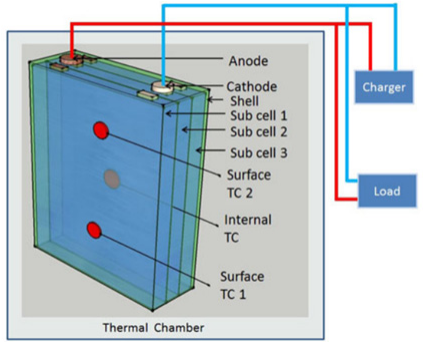
Figure 2. Configuration of battery internal system.